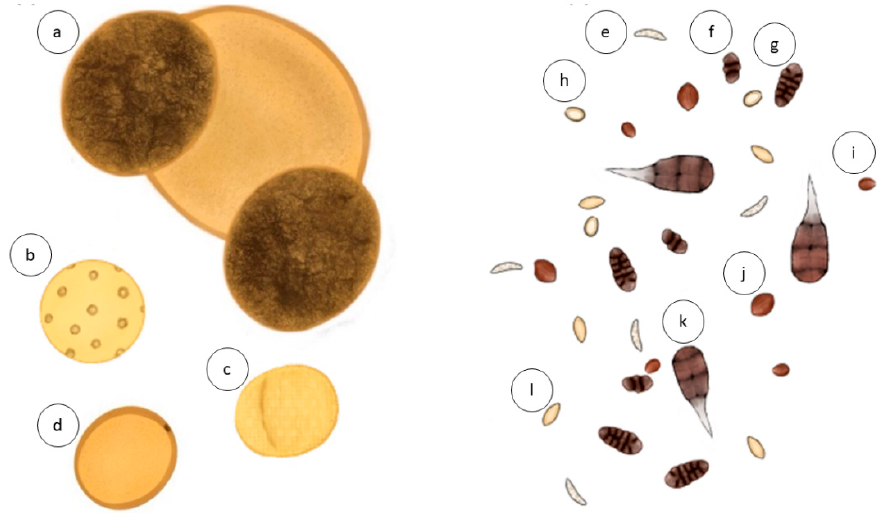
Figure 1. Visualization of the diversity in shape, pigmentation, and ornamentation amongst pollen grains ( left ) and fungal spores ( right ). Pollen grains commonly feature pores, colpi, or reticulated mesh. In contrast, fungal spores have more diverse shapes and ornamented textures. Image features artistic representations of Pine ( Pinaceae ) pollen ( a ), Plantain ( Plantago ) pollen ( b ), Olive ( Oleaceae ) pollen ( c ), Grass ( Poaceae ) pollen ( d ), Leptosphaeria spp. spores ( e ), Pithomyces spp. spores ( f ), Pleospora spp. spores ( g ), Ganoderma spp. spores ( h ), Coprinus spp. spores ( i ), Chaetomium spp. spores ( j ), Alternaria spp. spores ( k ), and Cladosporium spp. spores ( l ).